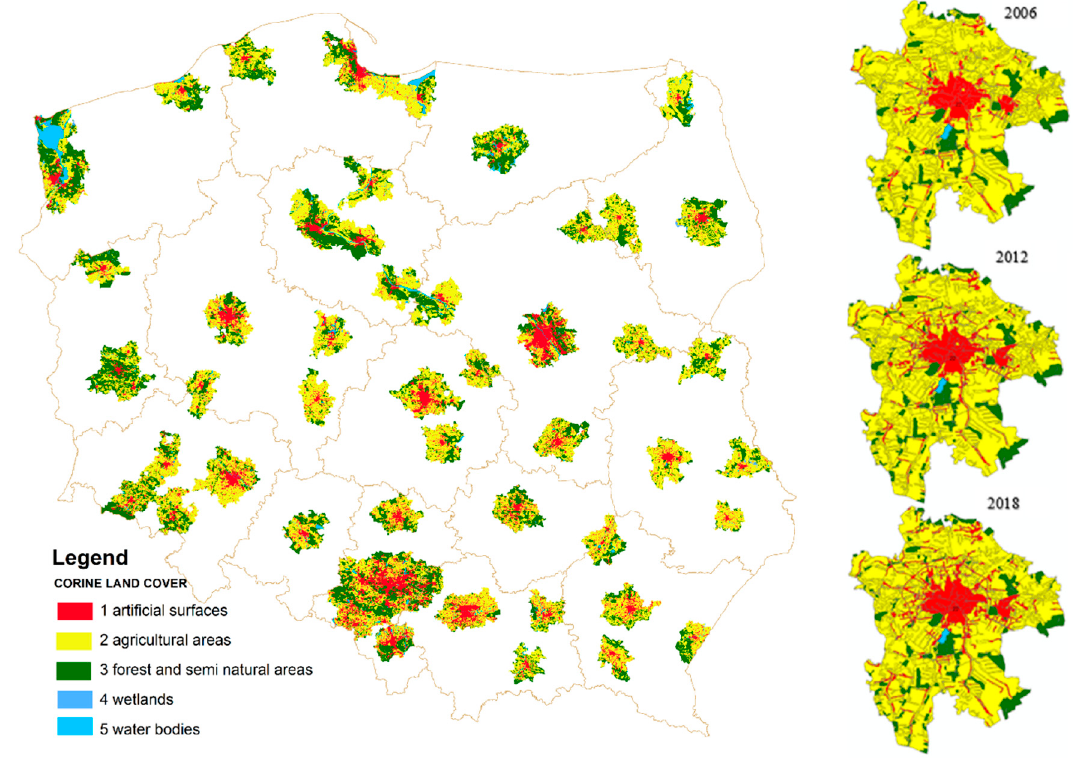
Figure 5. Land cover map of the analyzed areas based on CLC data (level 1). Source: own elaboration.